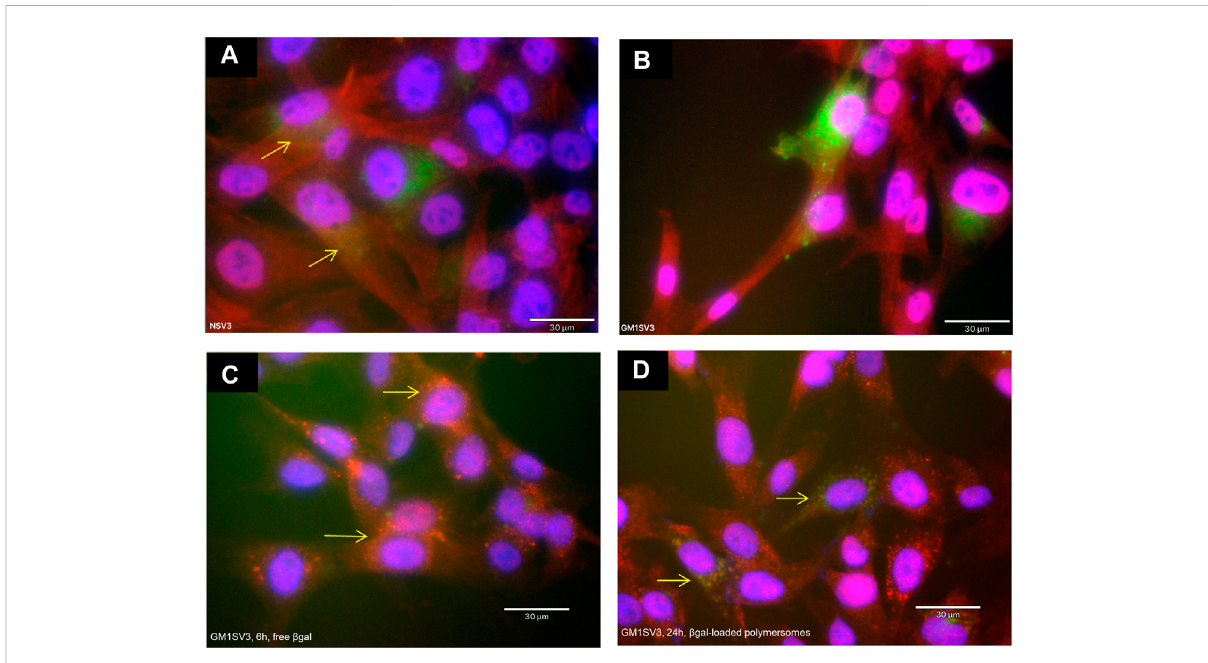
FIGURE 7 Autophagic behavior of (A) untreated healthy (NSV3) cells, (B) untreated diseased (GM1SV3) cells, after treating GM1SV3 cells with (C) free β - galactosidase ( β gal) for 6 h and ( D) β gal-loaded hyaluronic acid-polylactic acid (HA-PLA) polymersomes for 24 h (Scale bar = 30 μ m). These results show that treatment with β gal-loaded HA-PLA polymersomes causes the autophagy of diseased cells to look more like healthy